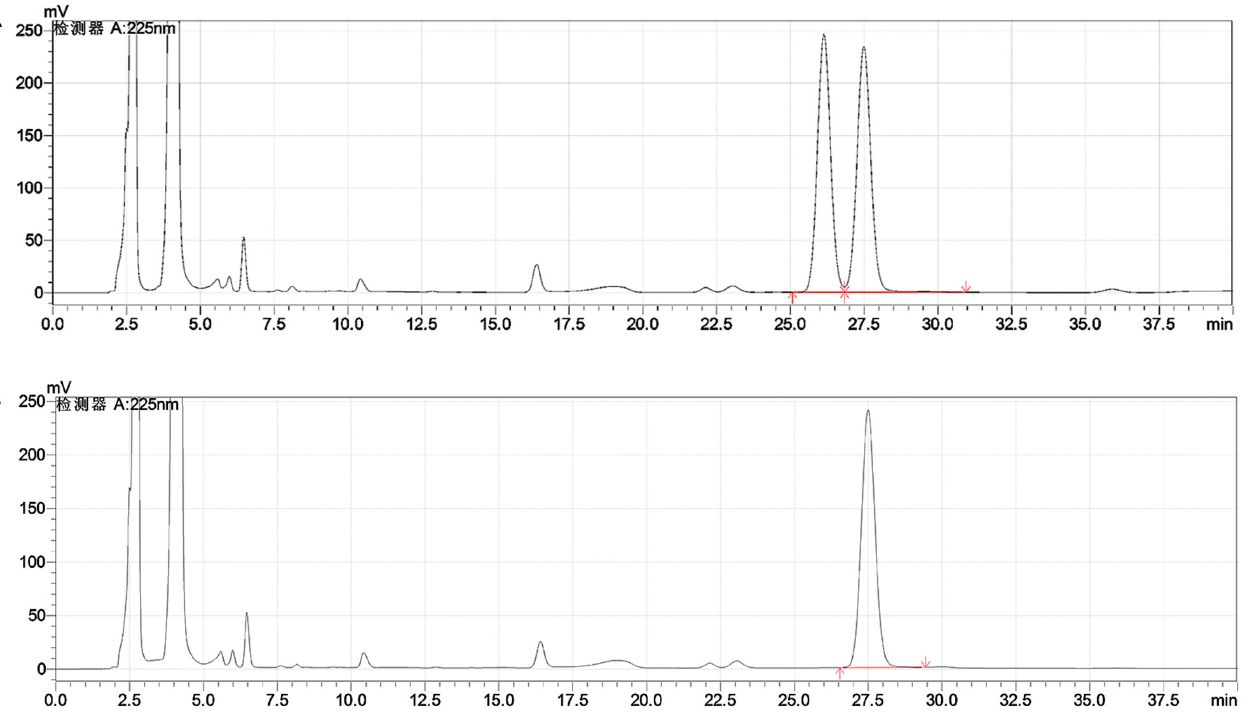
FIGURE 5a - (a) HPLC chromatogram of ( R )-NEA derivative of DL-malic acid (standard solution). The duration of retention for the chromatographic peaks of D-malic derivative and L-malic acid derivative was 26.1 and 27.5 min, respectively. (b) HPLC chromatogram of ( R )-NEA derivative of L-malic acid (standard